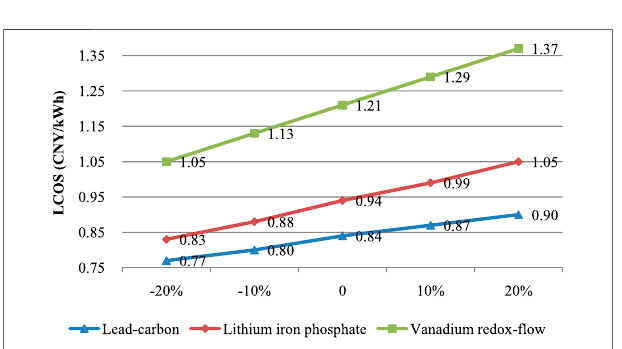
FIGURE 11 | Sensitivity analysis of the unit initial investment cost to the LCOS of EES.